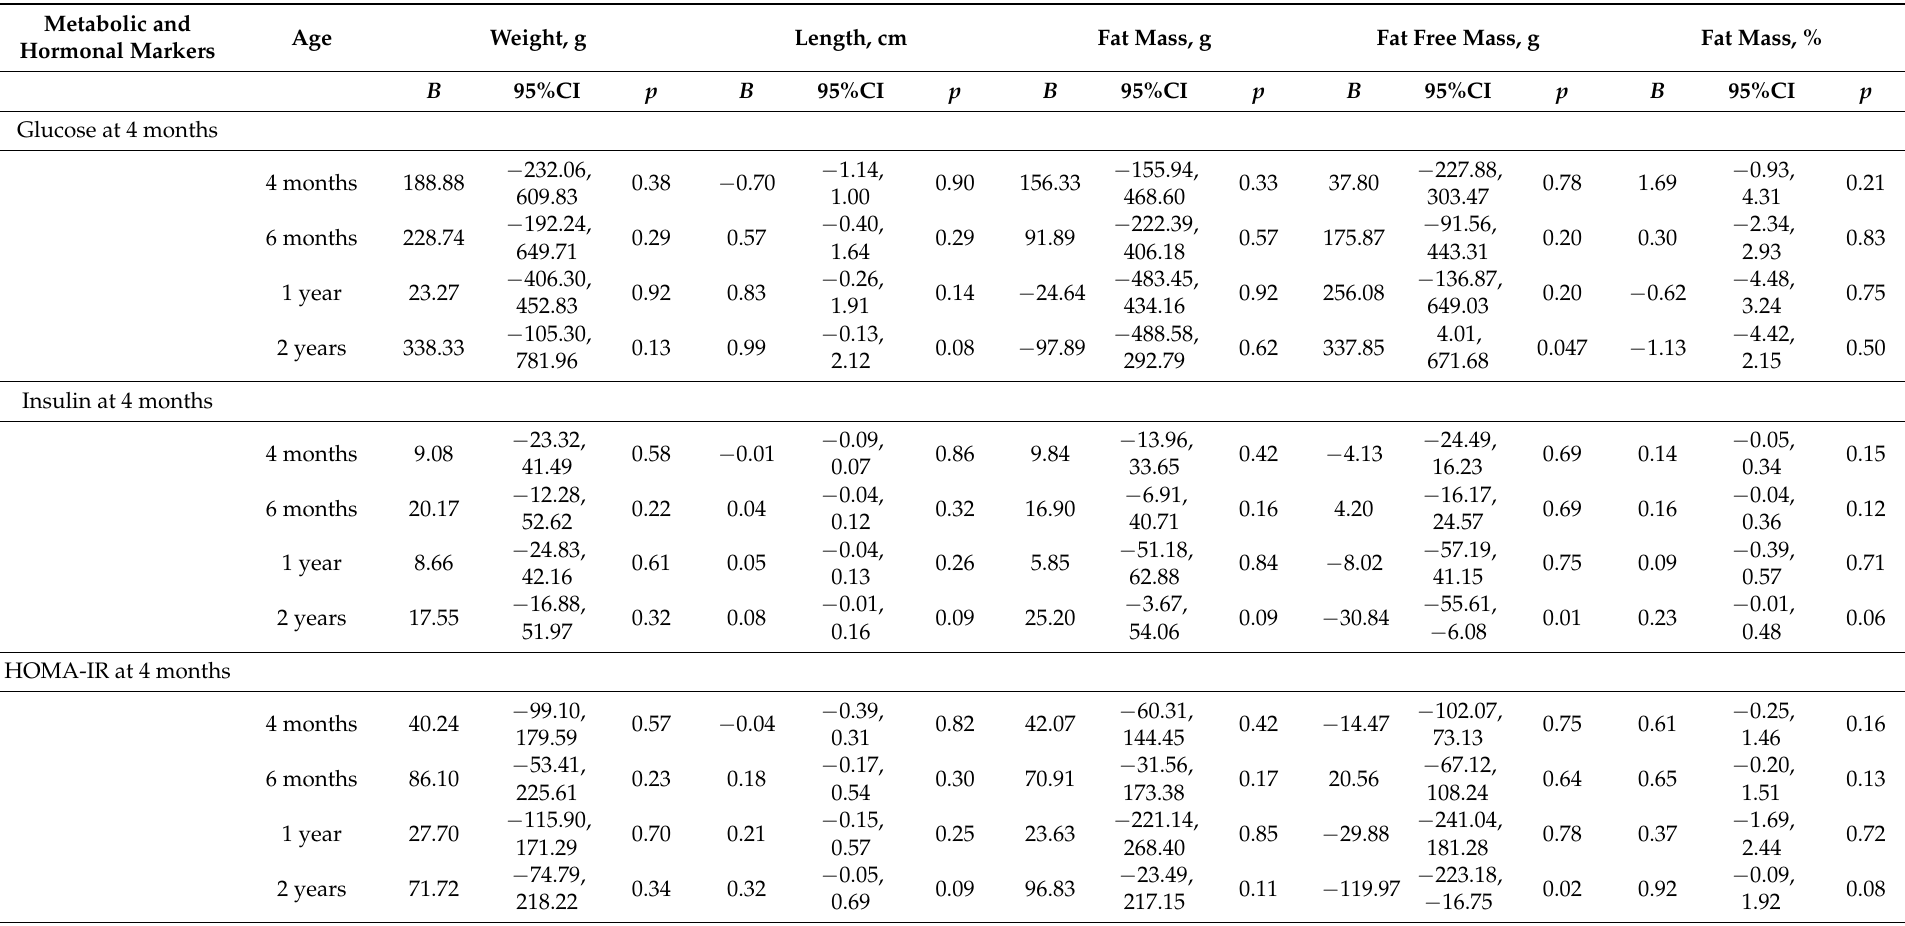
Table 5. Metabolic and hormonal markers at 4 months in relation to anthropometric parameters and body composition through the age of 2 years. Metabolic and Hormonal